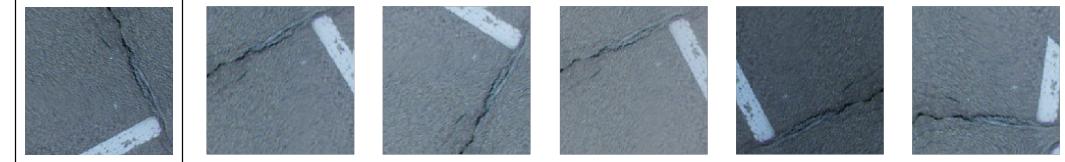
Figure 7. The original training sample (left, framed) and its transformations that can potentially be used for data